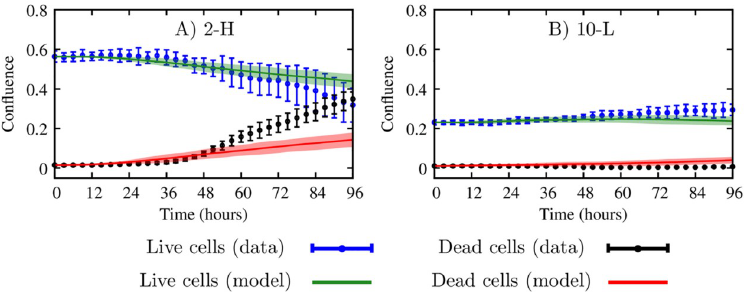
Fig 13. Model predictions of scenarios 2-H and 10-L. Leave-one-out prediction of scenarios 2-H (A) and 10-L (B). The cgABM was calibrated using the time-resolved microscopy data for all scenarios, excluding 2-H (panel A) and 10-L (panel B). The data mean and 95% credible interval for the live and dead cells are shown in blue and black, respectively. The mean of the simulation is represented as a solid line, and the area is the 95% credible interval for the live (green) and dead (red) cells. The average error and standard deviation for live and dead cells in scenario 2-H are 13.97 ± 3.69% and 15.80 ± 5.59%, respectively. While that for scenario 10-M are 7.61 ± 2.01% and 5.78 ± 1.13%,